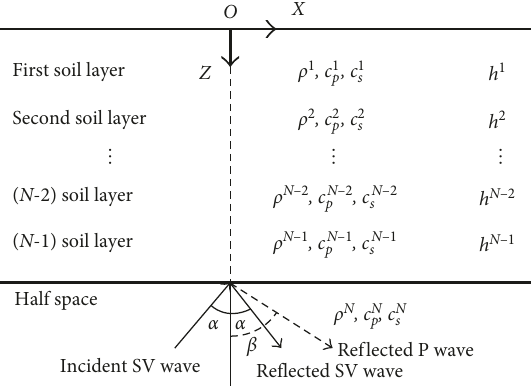
Figure 1: Layered site model of SV wave under oblique